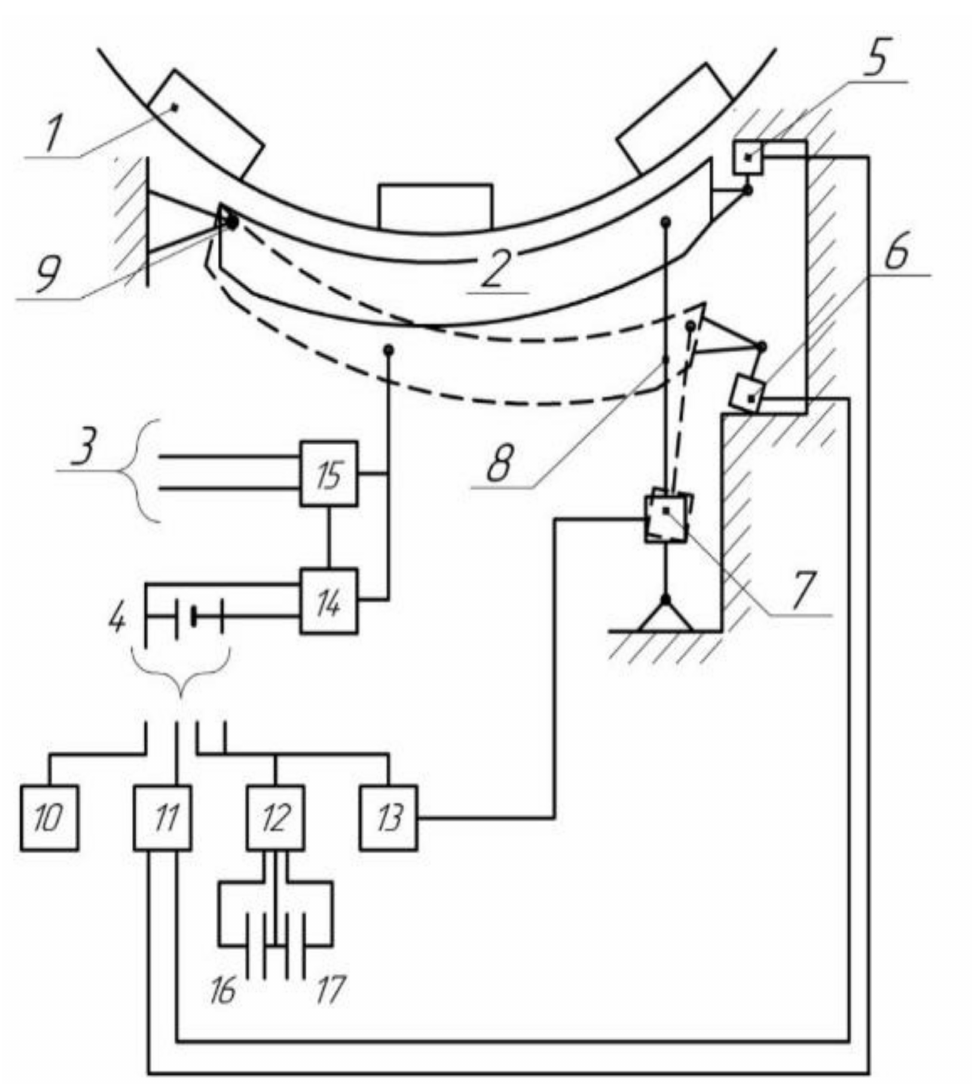
Figure 1. Drive structure: the device also includes the approach and departure limit switches (5) and (6), drive (7), rod (8), bearing (9), program setter (seasonal wind corrector) (10), regulator (11), switch (12), inverter (13), rectifier (14), inverter (15), and capacitors (16) and